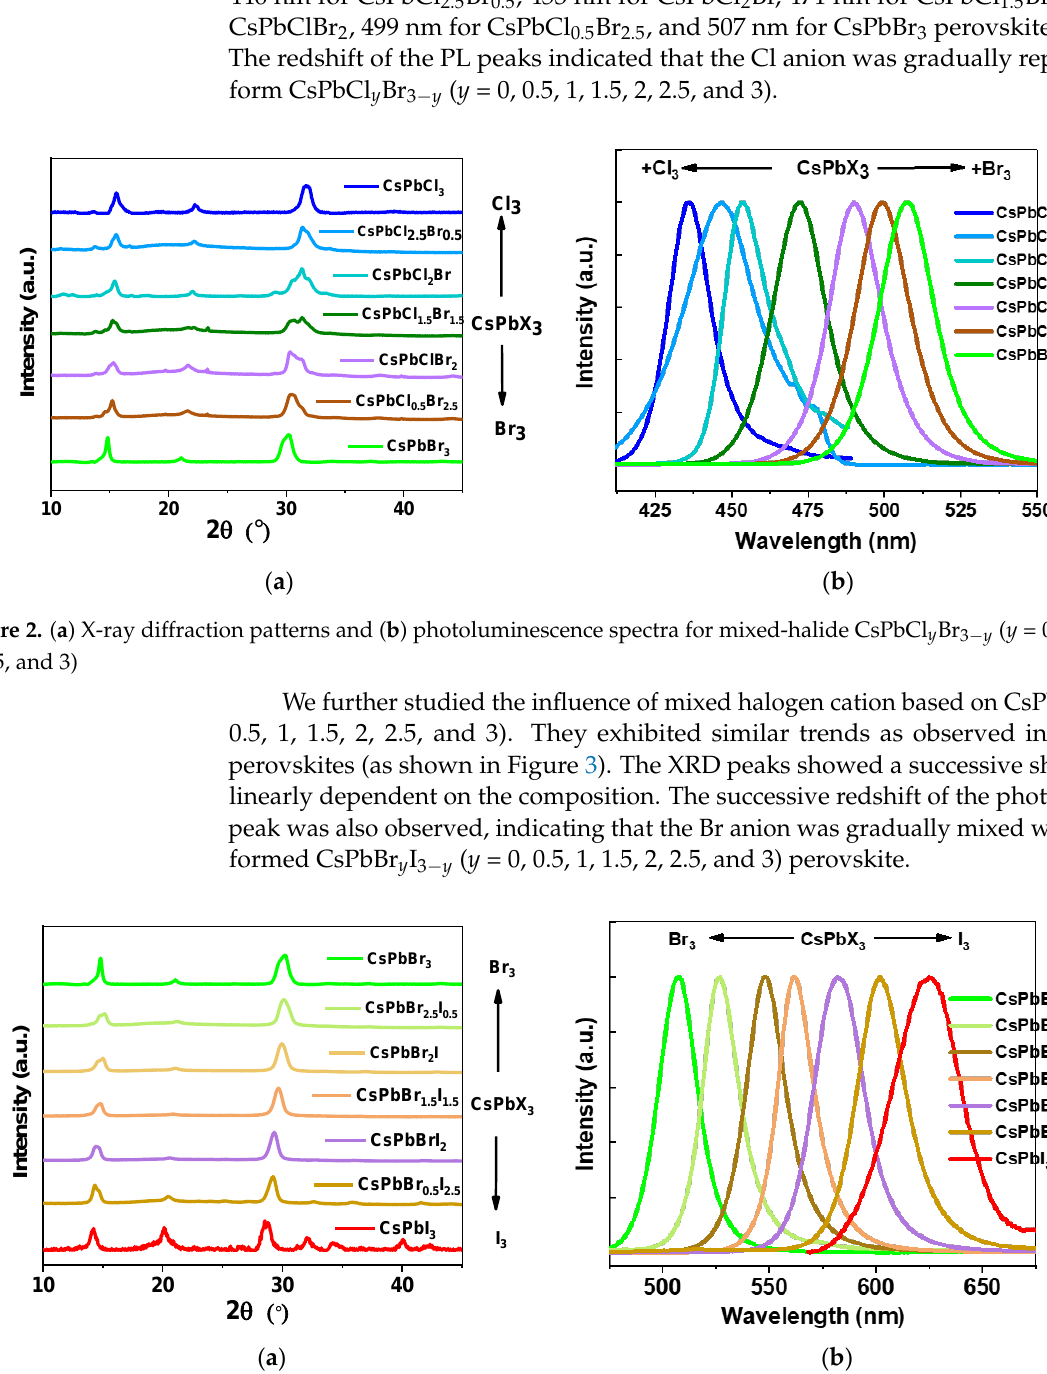
Figure 3. ( a ) X-ray diffraction patterns and ( b ) photoluminescence spectra for mixed-halide CsPbBr y I 3 − y ( y = 0, 0.5, 1, 1.5, 2, 2.5, and 3).